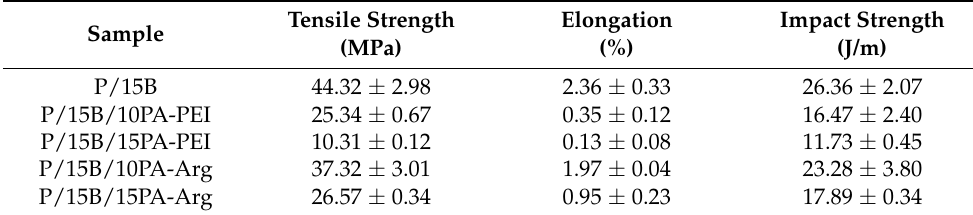
Figure 6. ( a ) Tensile strength and elongation strength at break, ( b ) impact strength of P/15B-based biocomposites. Table 4. Mechanical properties of P/15B-based bicomposites.